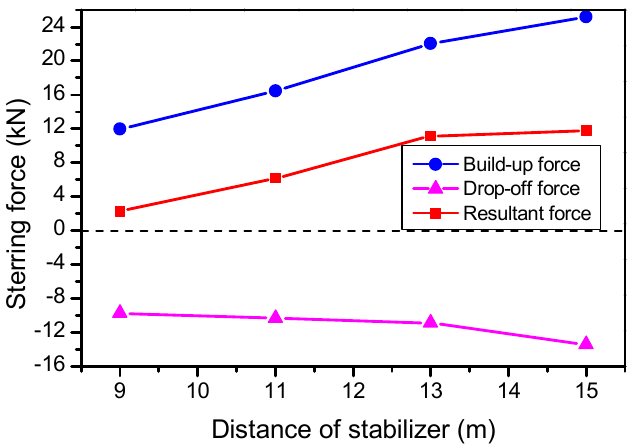
Figure 17. Steering force versus stabilizers’ location.